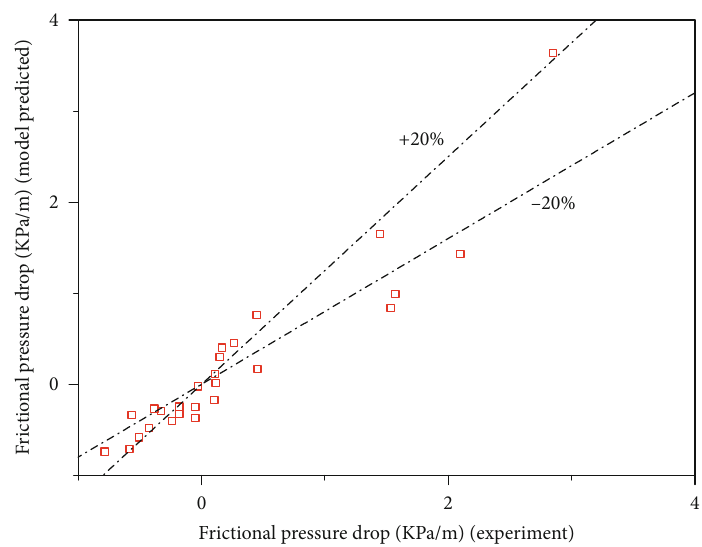
Figure 7: Measured data vs. predicted of Taitel [32] model (frictional pressure drop).